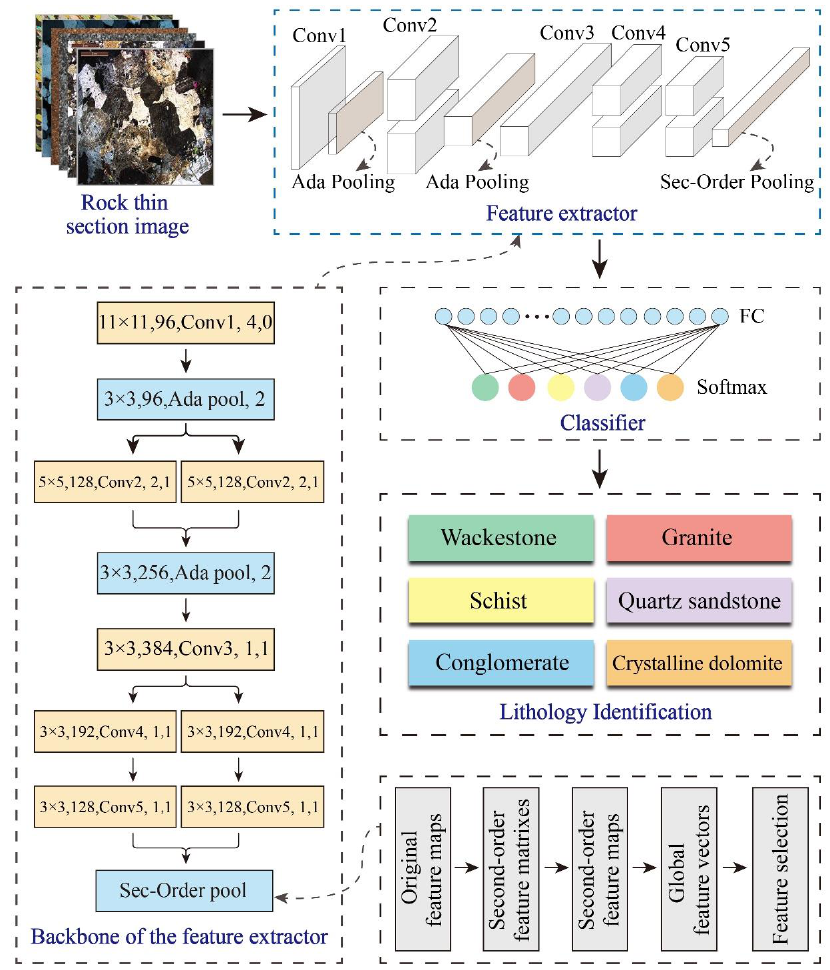
Figure 4. The structure of rock thin section image identification model (ASOPCNN).